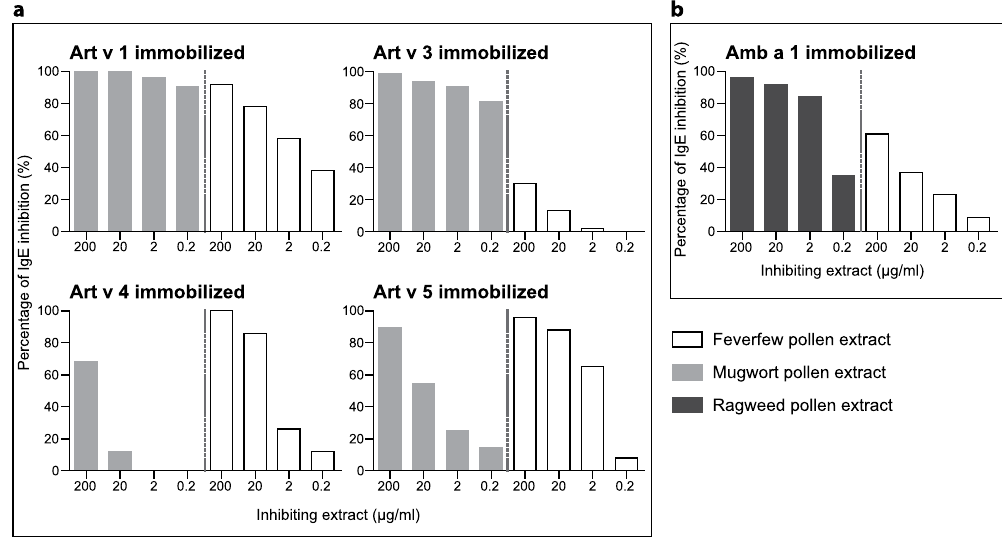
Figure 5. Feverfew pollen inhibits IgE reactivity to allergens from mugwort and ragweed. Purified weed pollen allergens were immobilized on ELISA plates. A pool of patients’ sera (n = 6) was pre-incubated with different concentrations of ( a ), mugwort (self-inhibition control) and feverfew pollen extract or ( b ), ragweed (self- inhibition control) and feverfew pollen extract. The sensitization profile to the single allergens of the patients’ pool is shown in the Supplementary Table